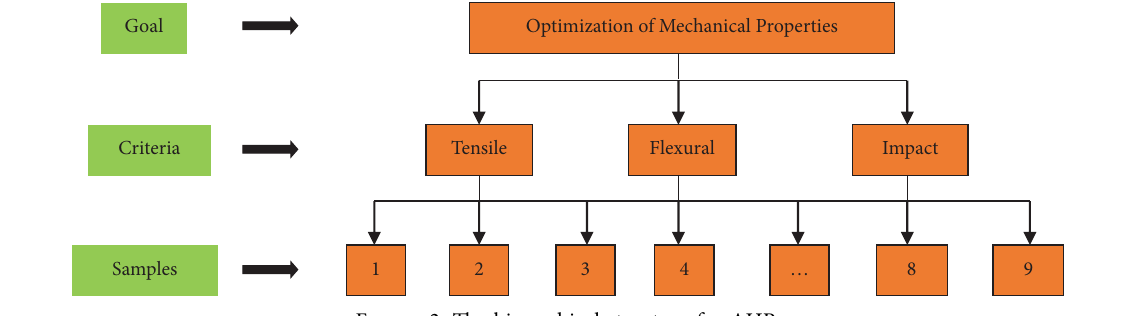
Figure 2: +e hierarchical structure for AHP. Table 2: rating scale for developing the pair-wise comparison matrix of